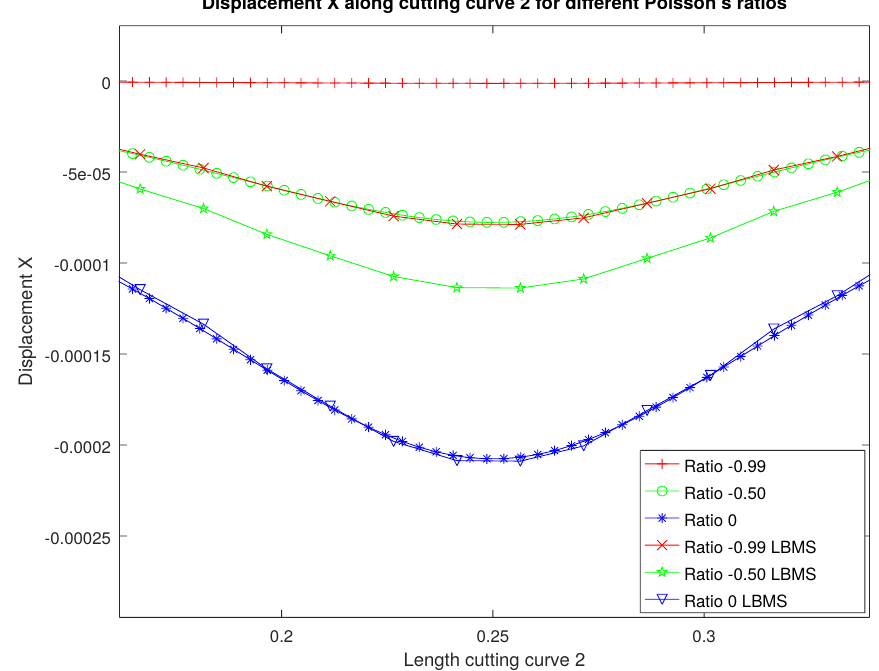
Figure A8. Detailed view of first displacement components along cutting curve C 2 for negative Poisson’s